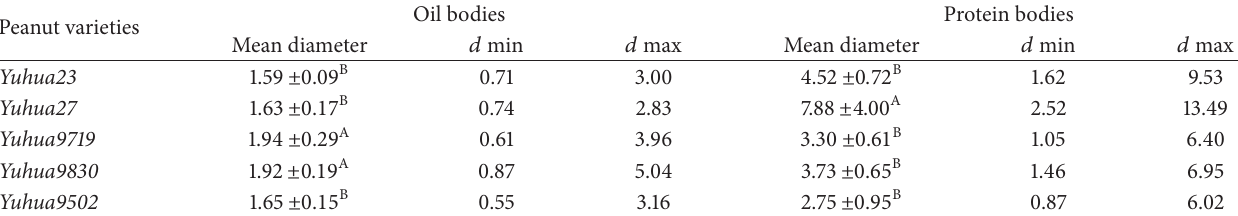
Table 2: Oil bodies and protein bodies diameter (mean ± standard deviation) and minimum ( 𝑑 min) and maximum diameter ( 𝑑 max) ( 𝜇 m). Oil bodies Protein bodies Peanut varieties Mean diameter 𝑑 min 𝑑 max Mean diameter 𝑑 min